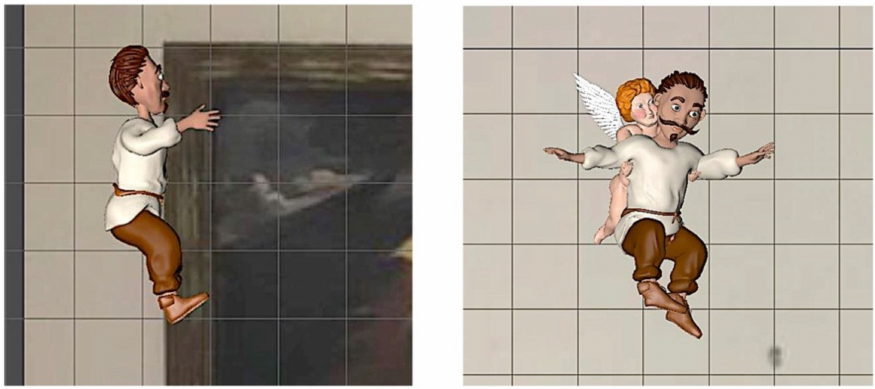
Figure 4. ( Left ): Mercurio climbs onto the frame of the first painting. ( Right ): the angel grabs Mercurio in order to carry him from one painting to